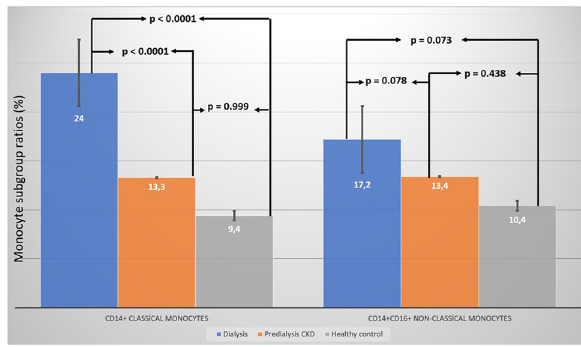
Figure 1: Classic and non-classic monocyte subgroup ratios in the patient groups and controls.